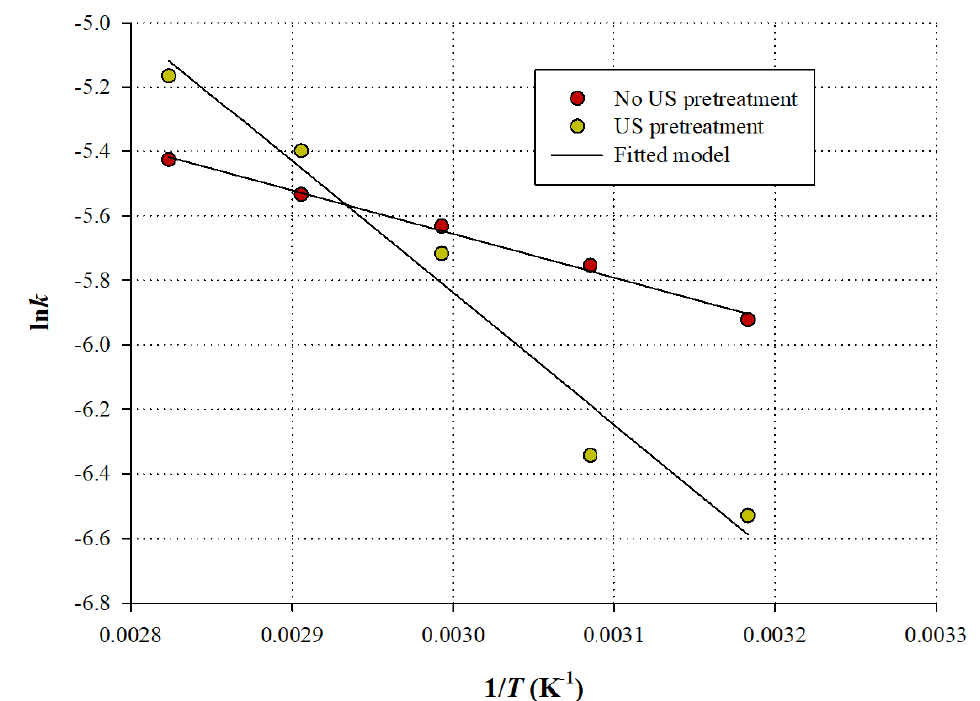
Figure 6. Arrhenius plot for the extractions with no pretreatment (No US) and ultrasonication pretreatment (US).